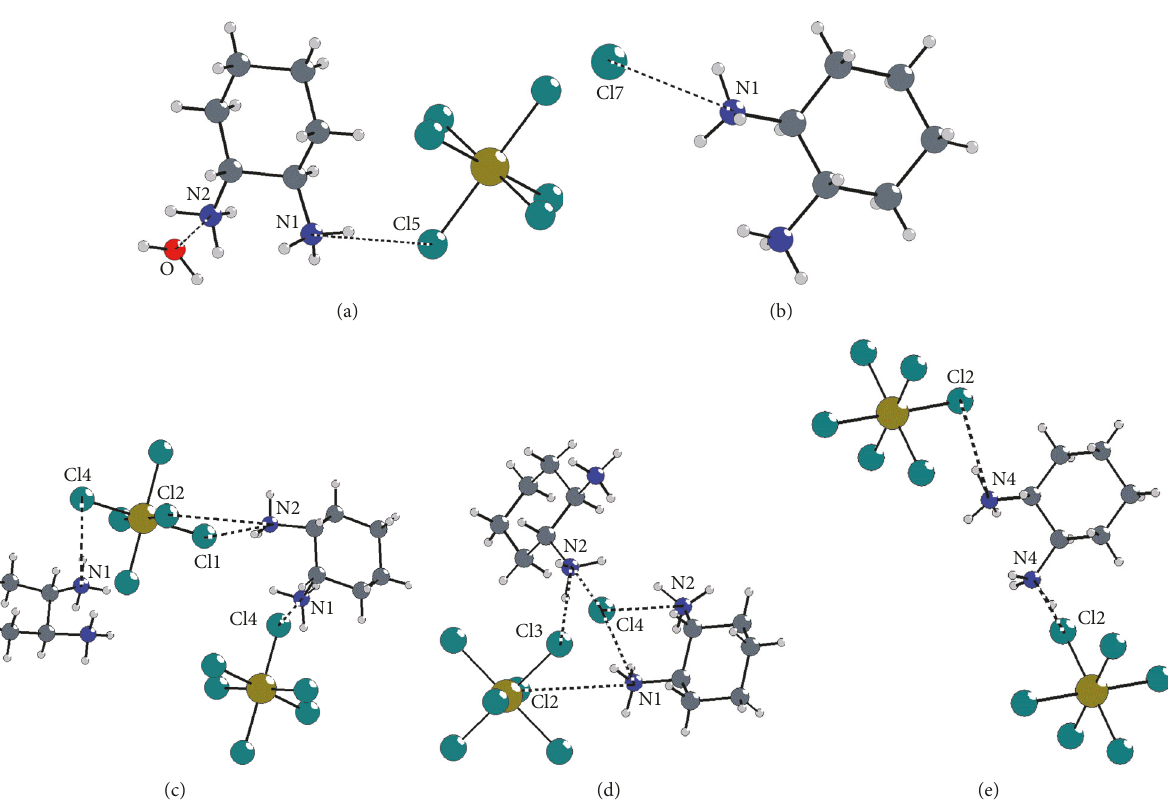
Figure 6: Configuration of hydrogen bonds in the studied compounds. (a) C 6 H 10 (NH 3 ) 2 [PtCl 6 ] ⋅ H 2 O (I) , (b) C 6 H 10 (NH 3 ) 2 [PtCl 6 ] ⋅ 2H b l (II) , (c) C 6 H 10 (NH 3 ) 2 [PtCl 6 ] (III) , (d) (C 6 H 10 (NH 3 ) 2 ) 2 [PtCl 6 ]Cl 2 (V) , and (e) C 6 H 10 (NH 3 ) 2 [PtCl 6 ] ⋅ H b l (VI)